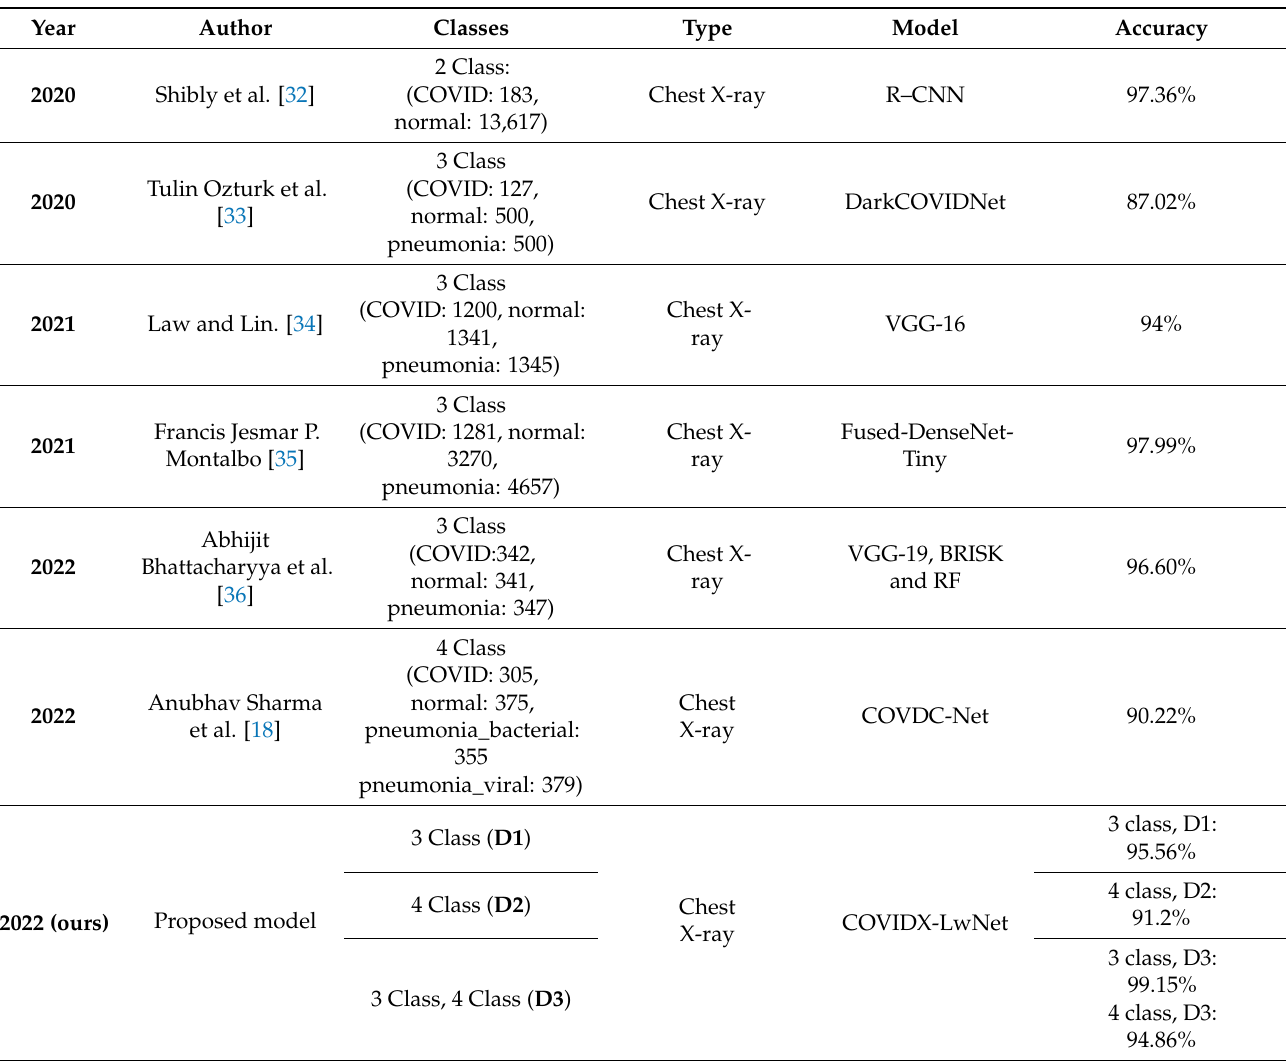
Table 13. Comparison of the proposed system with existing systems in terms of